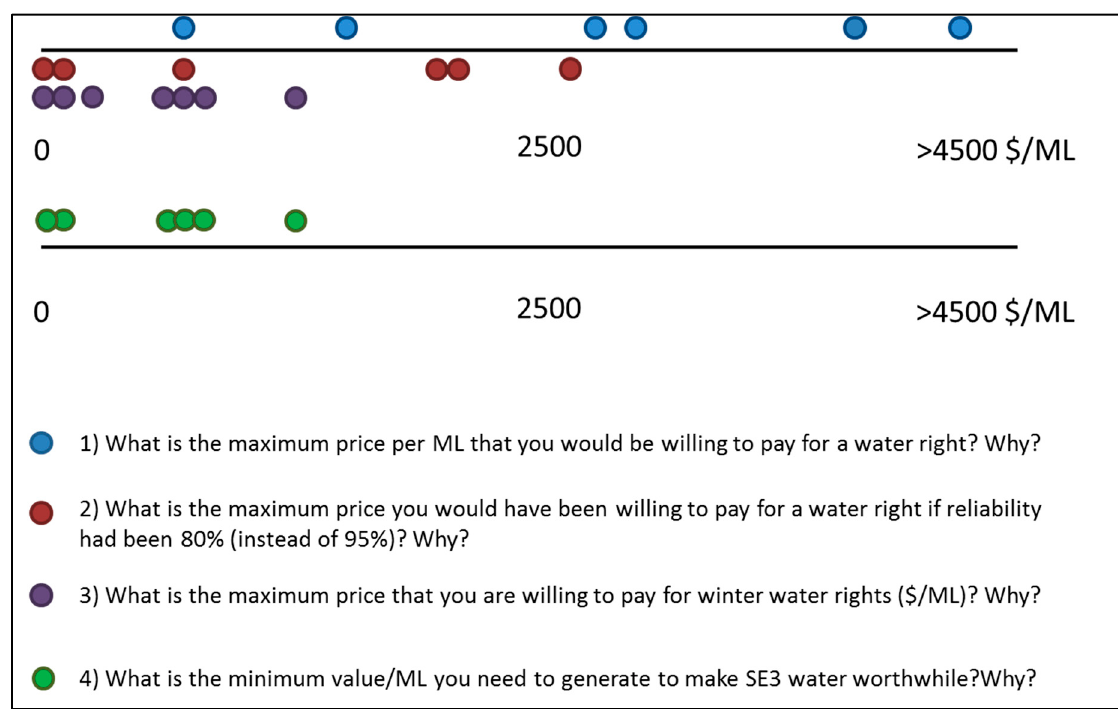
Figure 2. Responses to each question after discussion: Willingness to pay and minimum value generation.